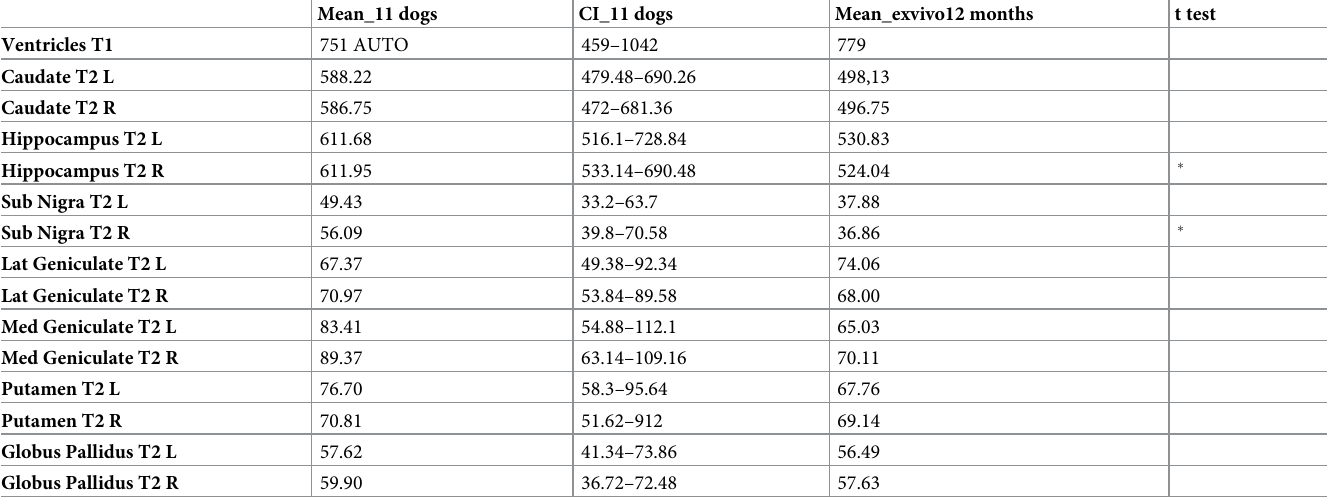
Table 2. Comparison between the measurements obtained on the group of 11 dogs after 12 months in formalin and the ones obtained on the single brain dog after 12 months in formalin. Mean values between the operators are reported for each structure for both the group of the 11 dogs and the single brain dog after 12 months in formalin. A t-test revealed that only Hippocampus right and Sub Nigra R a significant difference was obtained (marked as � ) between the two